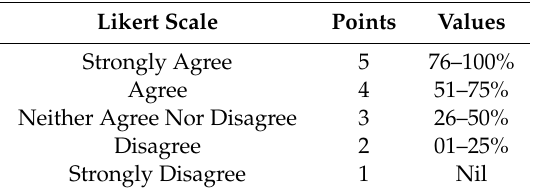
Table 6. Likert scale, the points and the